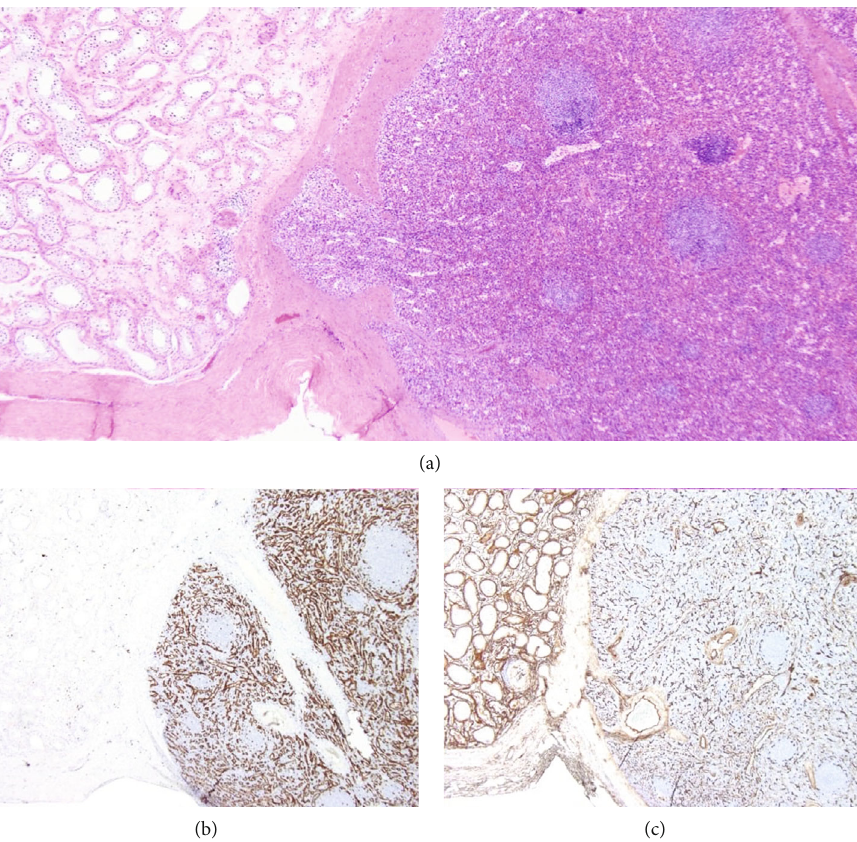
Figure 2: Pathologic specimen demonstrating (a) benign splenic tissue separated by fi brous cap, (b) CD8 staining of littoral cells, and (c) CD34 staining of endothelial